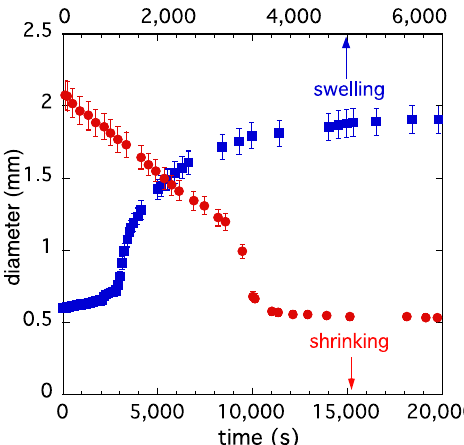
Figure 7. Kinetics of swelling (squares) and shrinking (circles) of a PA hydrogel. Gel was shrunken in 40 mM NaCl solution containing 10 mM CaCl 2 solution and reswollen in 40 mM NaCl solution (without CaCl 2 ).